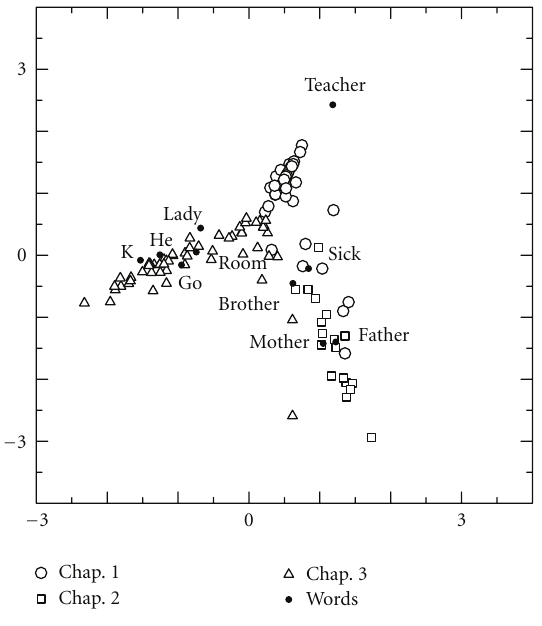
Figure 4: Document-keyword biplots